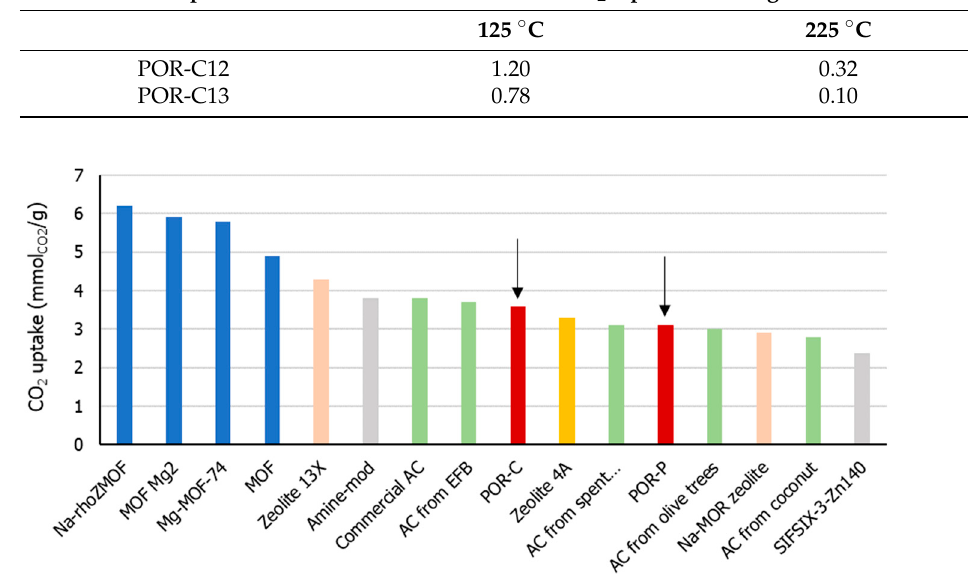
Figure 7. Carbon dioxide uptake for different adsorbent materials. Ref: Na-rhoZMOF [14,29], MOF Mg 2 (dobdc) [30], Mg-MOF-74 [31], MOF Mg 2 (dobdc)(N 2 H 4 )1.8 (Mg 2 (dobdc)] (Amine-functionalized MOF H4dobdc = 2,5-dihydroxyl-1,4-benzenedicarboxylic acid) [29,32], Zeolite 13X [14,33],